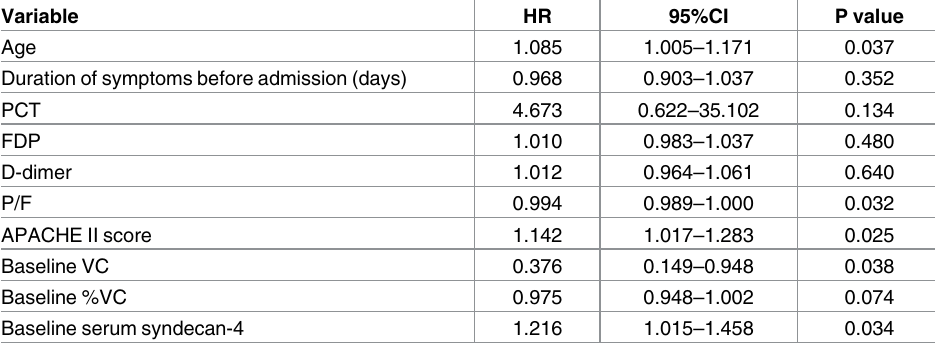
Table 5. Univariate analysis of survival prediction. Univariateanalysis.